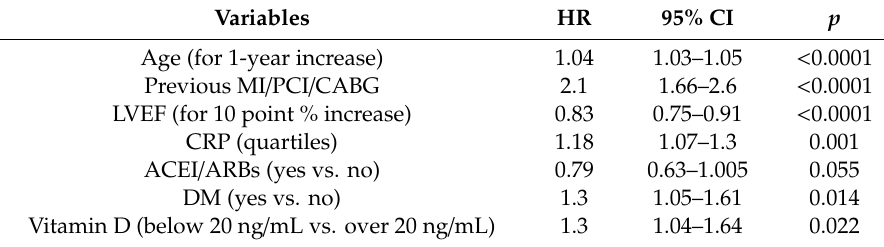
Table 2. Multivariable Cox proportional hazards regression analysis for primary composite end-point. Variables HR 95%